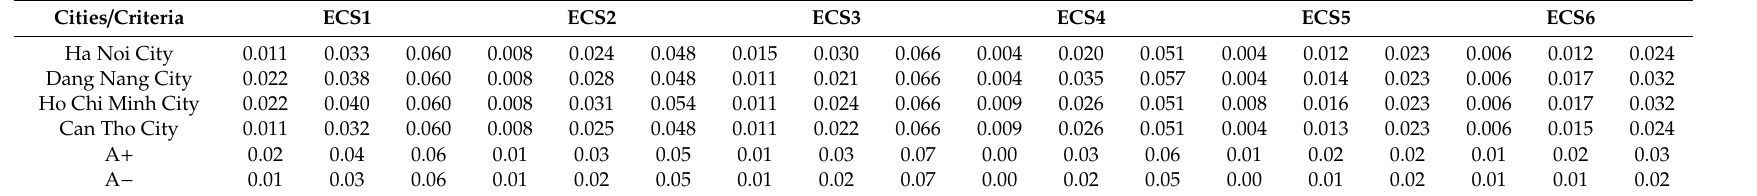
Table 13. Normalized fuzzy decision matrix, fuzzy positive-ideal, and fuzzy negative-ideal